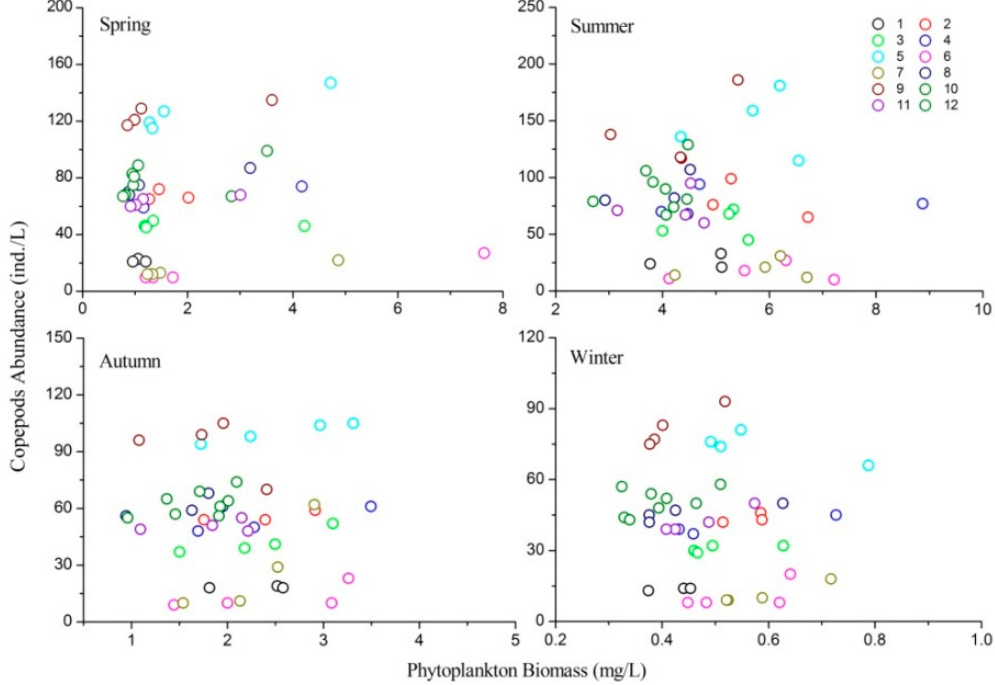
Figure 7. Relationships between phytoplankton biomass and copepod abundance in different seasons. Table 4. Linear Mixed Effects Model analyses for the relationship between phytoplankton biomass and copepod abundance in different seasons.